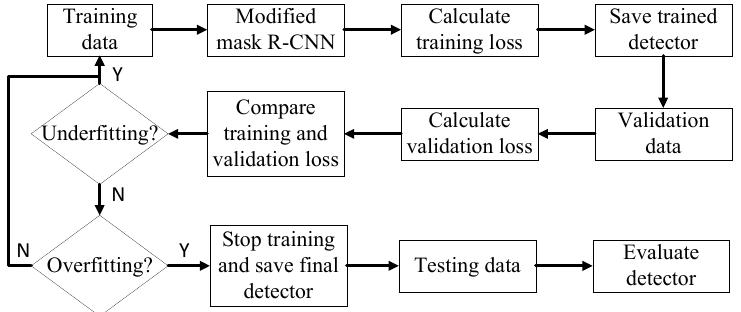
Figure 3. Illustration of the training, validation, and testing process. Mask R-CNN is mask region-based convolutional neural network. “Y” means that judgement is true and “N” means that judgement is false.